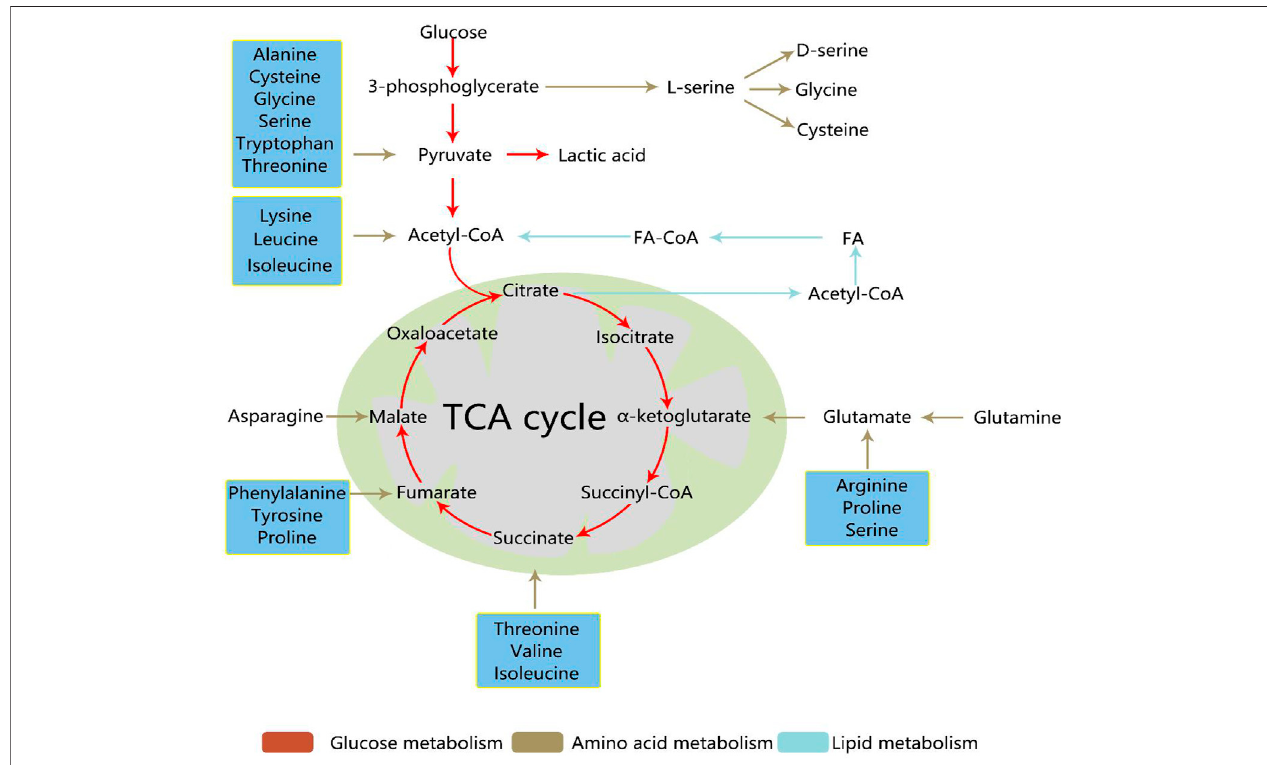
FIGURE 2 | The regulation of the three pathways of cancer cells and their crossover. During cancer development, metabolic reprogramming provides cancer cells the ability to survive and proliferate. Glucose, amino acid, and lipid metabolism are inseparable. Activated glycolysis and impaired aerobic respiration shape the altered glucosemetabolism.Inaddition,deregulatedanabolism/catabolismoffattyandaminoacids,especiallyglutamine,serine,andglycine,havebeenidenti fi edtofunctionas metabolic regulators in supporting cancer cell growth. TCA, tricarboxylic acid; FA, fatty acid; acetyl-CoA, acetyl coenzyme A; FA-CoA, fatty acetyl coenzyme A.